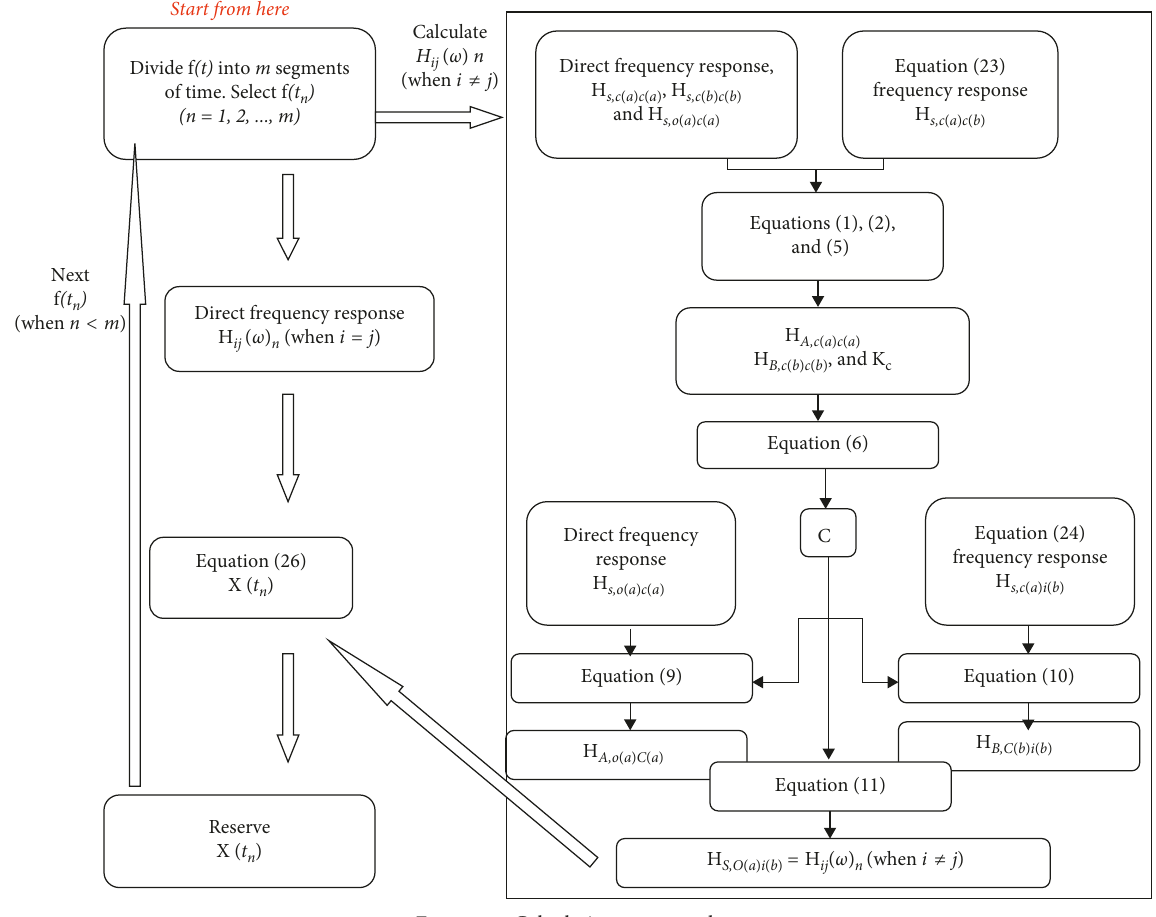
Figure 5: Calculation process chart.